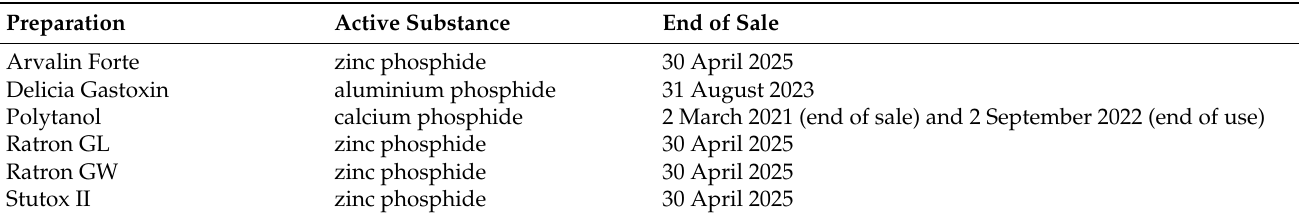
Table 7. The active ingredients and commercial preparations/formulations for control of the common vole registered in the CR in